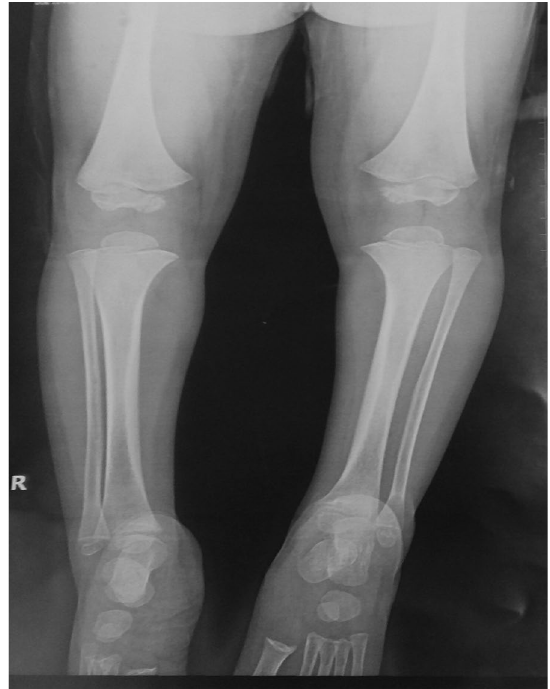
Fig. 2 Bilateral irregular femoral